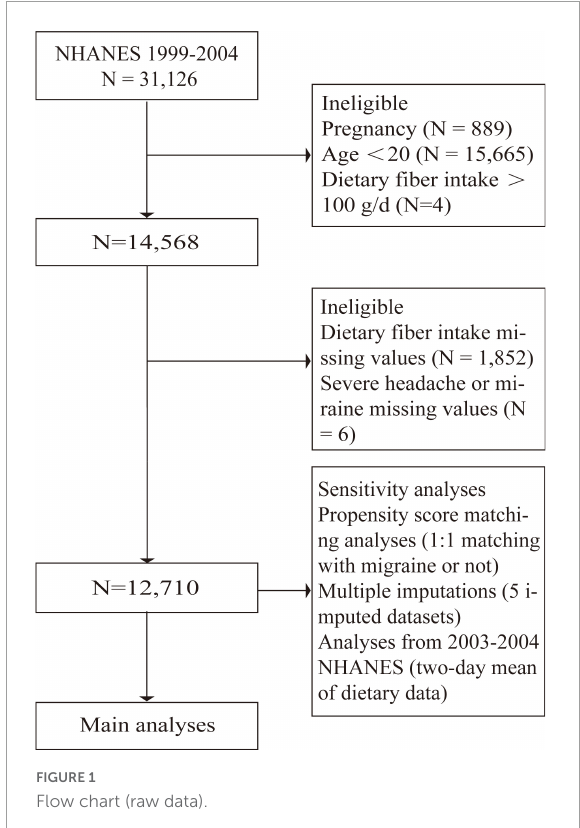
FIGURE1 Flow chart (raw data).